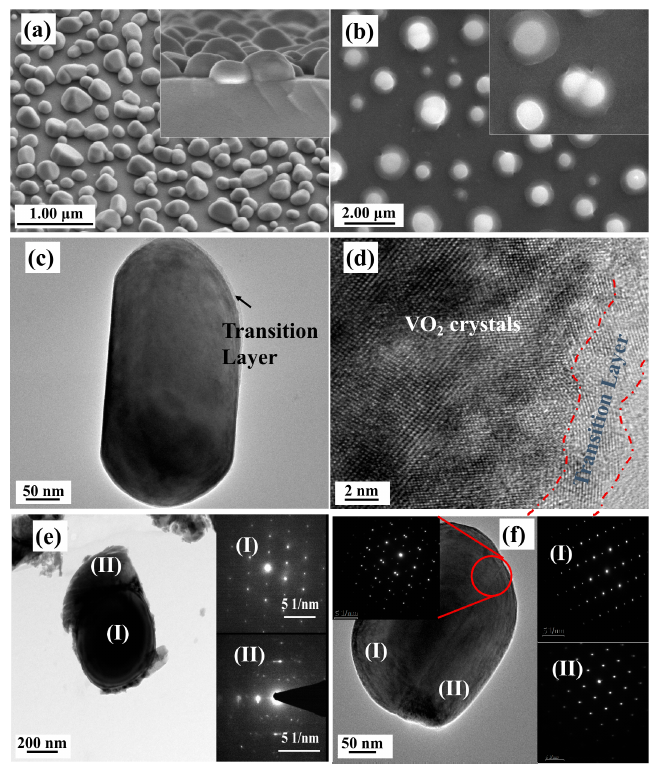
Figure 6. SEM and TEM characterization of VO 2 films annealed at 540 °C for 1 h with 0.20 kPa ( a , c , d ) and 0.24 kPa ( b , e , f ) oxygen injection. ( a ) 30° inclined surface image and a 15° inclined cross-section images (the inset) of a VO 2 film annealed with 0.20 kPa oxygen injection; ( b ) surface image of VO 2 film annealed with 0.24 kPa oxygen injection. ( c , d ) low magnification TEM and HRTEM images of sample a. The region marked with a dotted red line is a transition layer with oxygen rich vanadium oxides. ( e , f ) TEM images and SAED patterns of two individual particles from sample b, respectively. The SAED patterns in Figures 6e,f were taken from the areas marked in the corresponding low magnification TEM images.